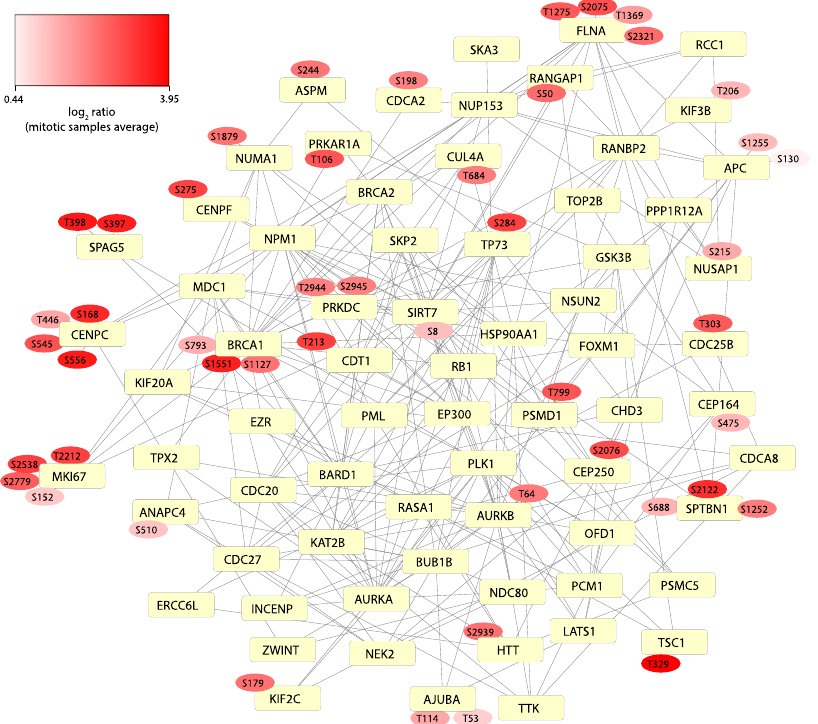
Figure 5. Cell cycle related novel putatively functional phospho-sites are highly connected in a protein- protein interaction network. The network represents interactions between proteins containing novel putatively functional phospho-sites annotated with the GO term “Cell cycle process”. Interactions of these proteins with other “Cell cycle process” annotated proteins are also included (see Methods for description of the network generation process). Square shaped nodes symbolize proteins (annotated by gene symbol) while round shaped nodes symbolize phosphorylation sites (detailed list available in Supplementary Data S5). Phosphorylation sites are color-coded by the average log 2 normalized ratio value across the three mitotic arrested samples. The network was generated using the Cytoscape software platform and the PhosphoPath plugin 28 . Protein interactions are retrieved by PhosphoPath based on the BioGRID database 66